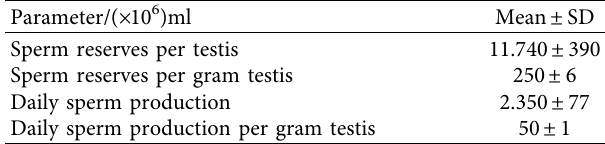
Table 2: Gonadal sperm reserves in Ghanaian WAD rams ( n � 12).